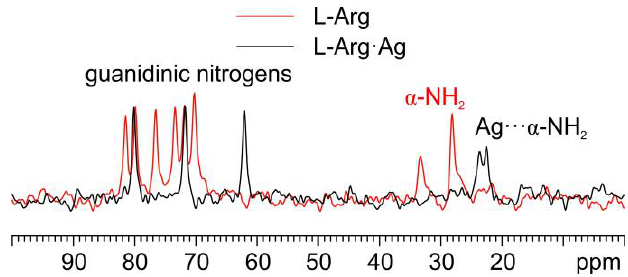
Figure 6. Overlay of a detail of the 15 N CPMAS spectra of L-Arg·Ag (in black) and pure L-Arg (in red).